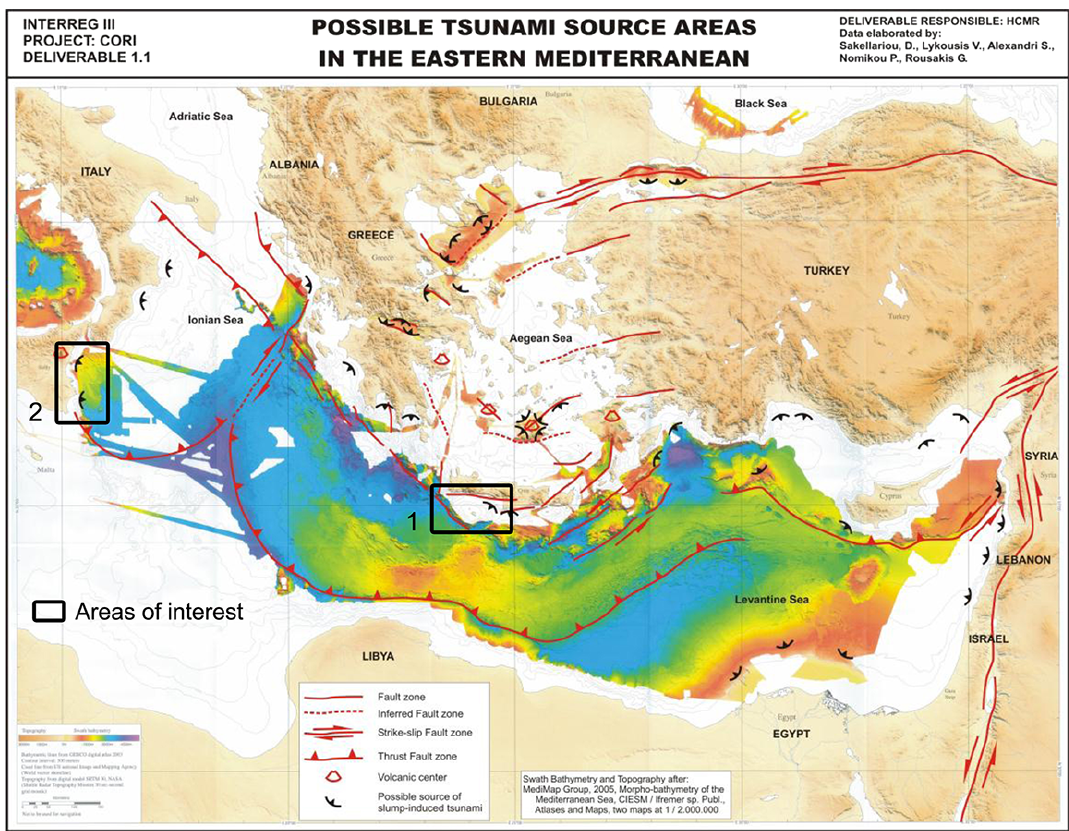
Figure 5. Possible tsunamigenic sources in the Eastern Mediterranean; the black rectangles outline the two areas of interest in the present work, comprising the sources of the earthquake-induced tsunami scenarios and the low-lying coastal areas where inundation phenomena were studied (adopted from Sakellariou et al., 2007; privately